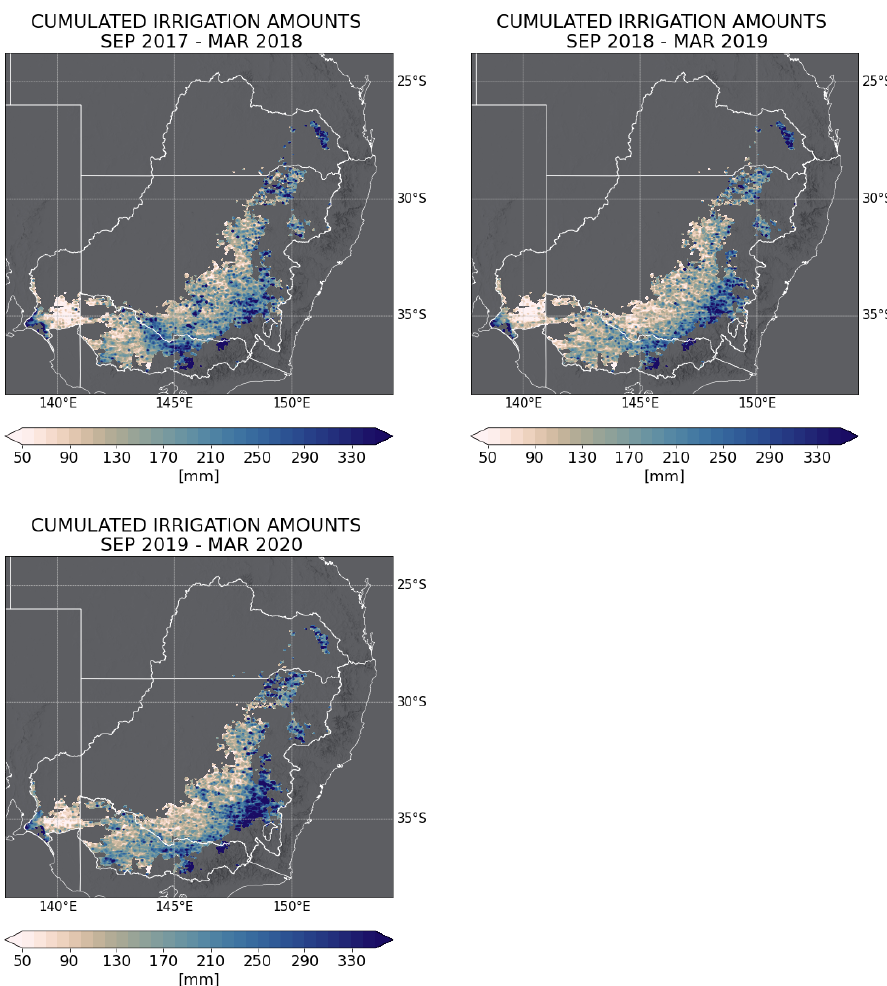
Figure 8. Cumulated irrigation amounts over the Murray–Darling basin (Australia) during the highest-intensity irrigation season (September–March) of 2017/18, 2018/19,